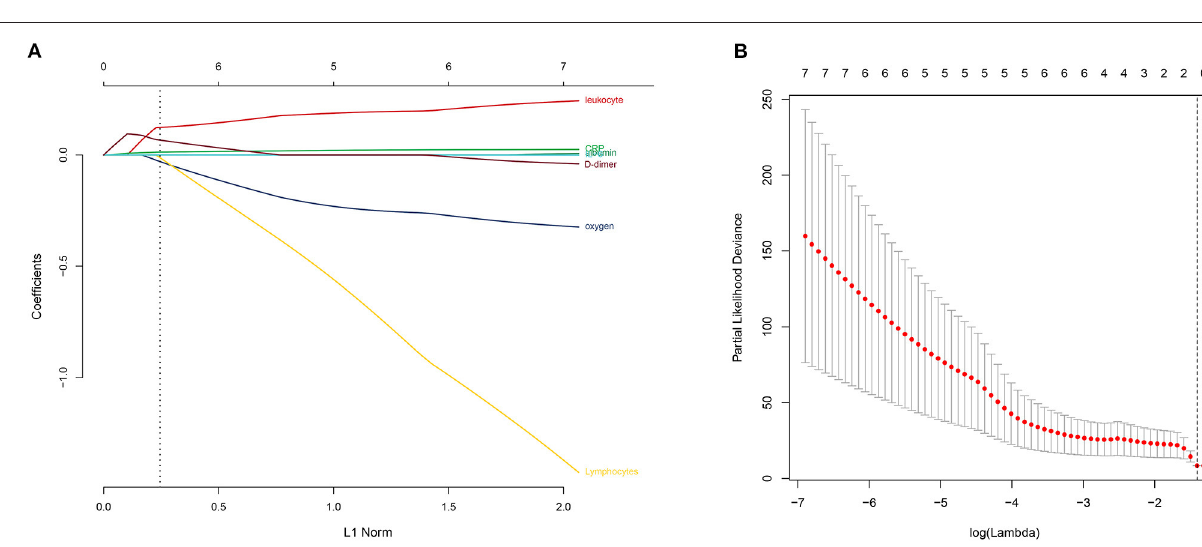
that the CRP levels increased from the common to critical clinical type patients, which is consistent with the earlier explanation.